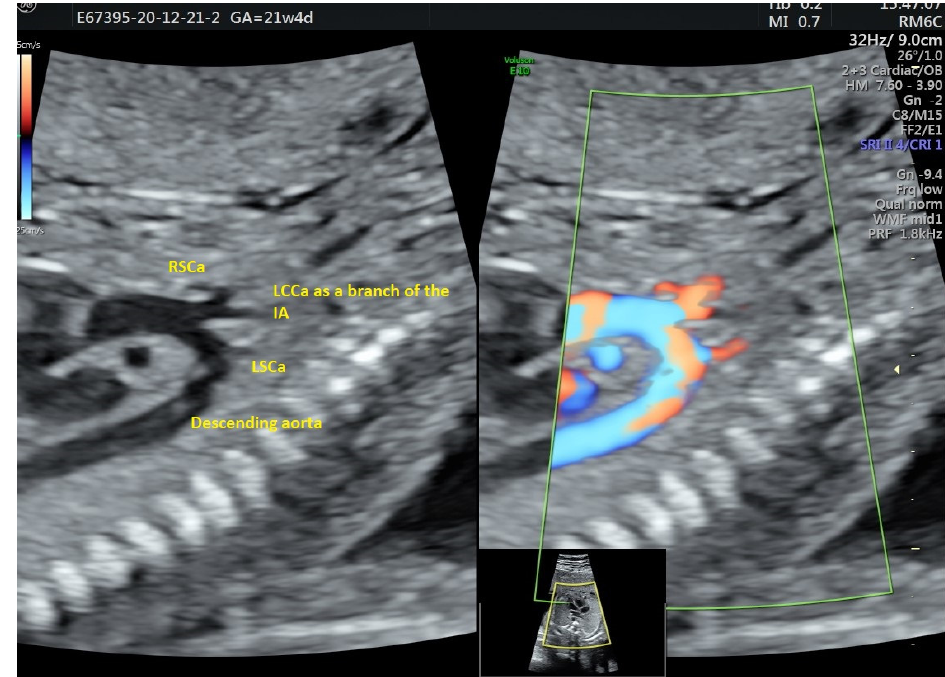
Figure 5. AAAV type A at 21 + 4 weeks, b mode and Doppler color, the common origin of IA and LCCa is more obvious on Doppler mode.